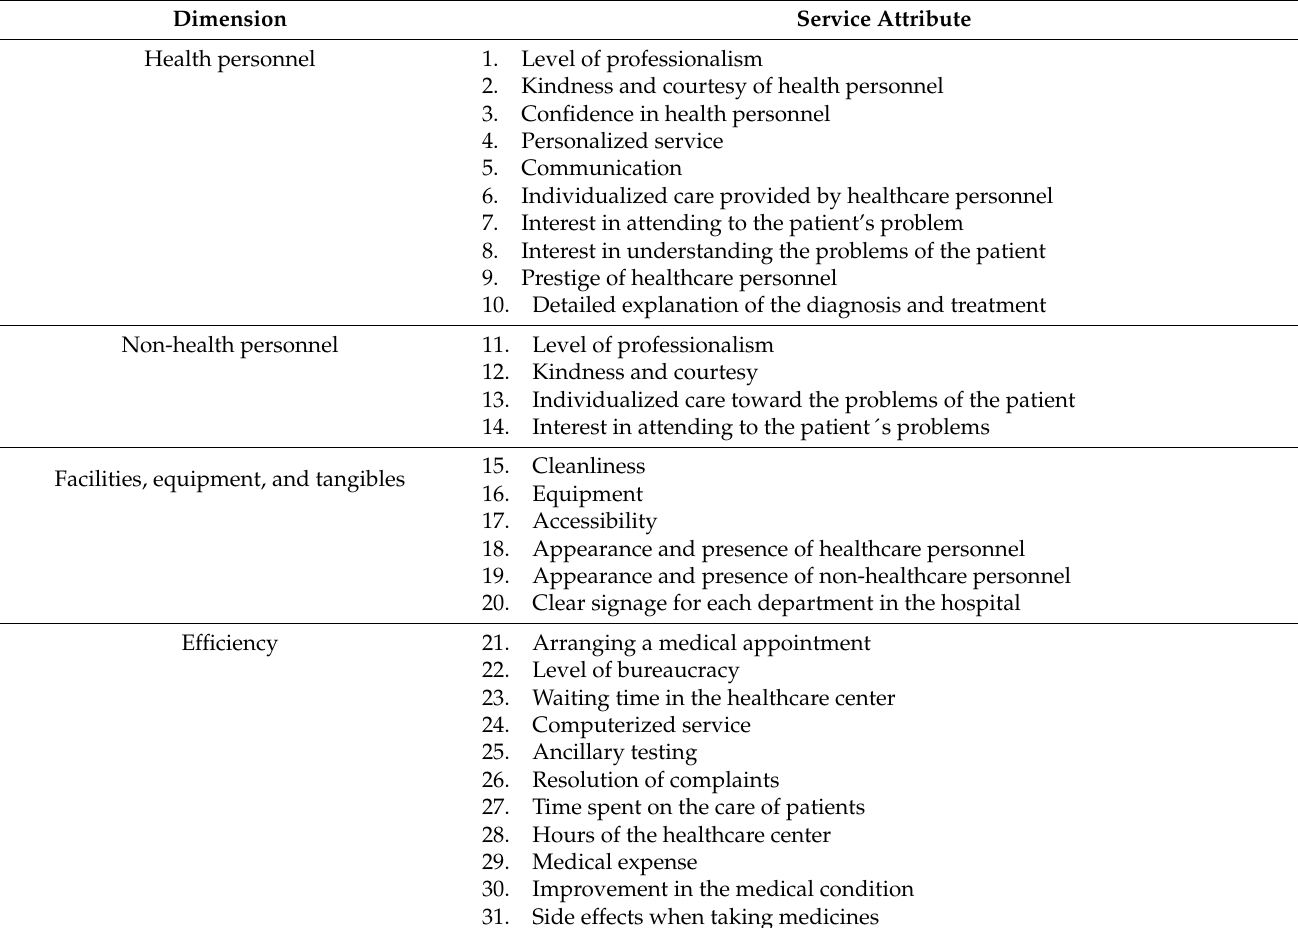
Table 1. Description of the dimensions and attributes evaluated in this